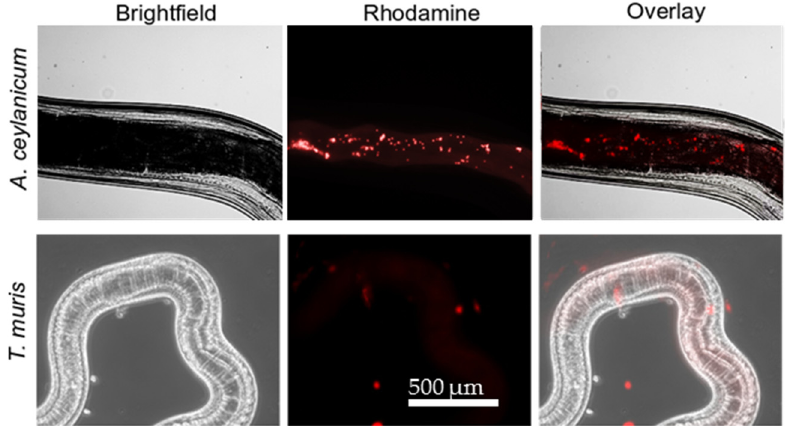
Figure 7. Microscopy pictures showing the ingestion of YPs by hookworms, but not whipworms, after a 24 h incubation with rhodamine-labeled YPs.